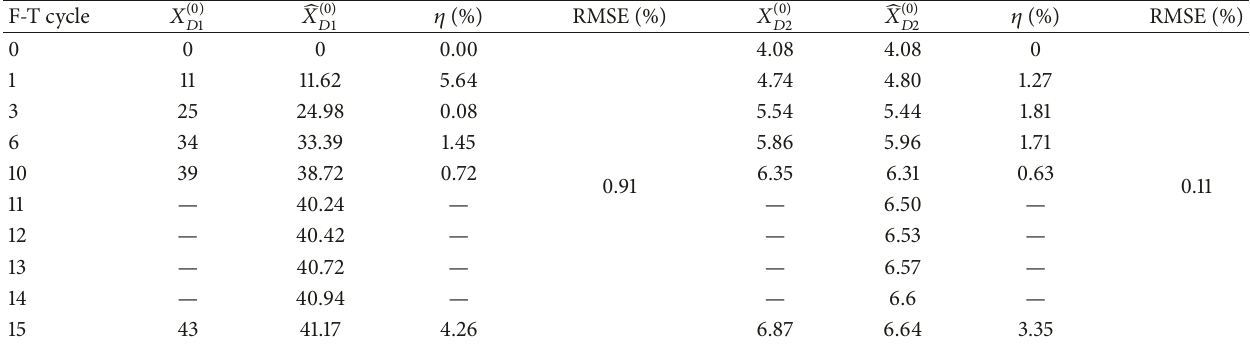
Table 14: Prediction results of 𝑋 (0) 𝐷1 and 𝑋 (0) 𝐷2 for CRDSMA based on MGM (1, 2).